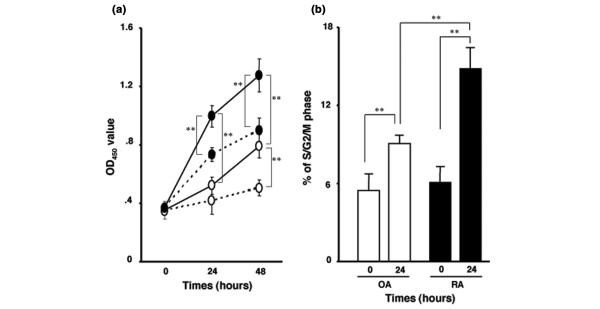
Effects of thrombin on proliferation and cell cycle in SFs from RA and OA. Cells were cultured for 48 hours in DMEM containing 1% FCS and then stimulated with 10 units/ml thrombin. (a) Time-course of proliferation of synovial fibroblasts (SFs) from patients with rheumatoid arthritis (RA) (dark symbols) and patients with osteoarthritis (OA) (light symbols). Continuous lines, thrombin-stimulated cells; dotted lines, unstimulated cells. The optical density (OD) was measured by ELISA plate reader at 450 nm. (b) Comparison of cell cycle in RA SFs and OA SFs. Numbers represent the percentage of cells exhibiting mean channel fluorescence (FL2-H) in the S/G2/M phase of the cell-division cycle. Data are expressed as mean ± standard deviation of five experiments, using five independent donors. **P < 0.01.